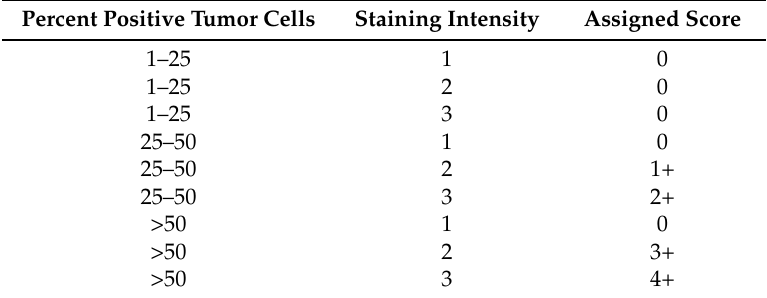
Table 4. Scoring system for evaluation of TAA expression by